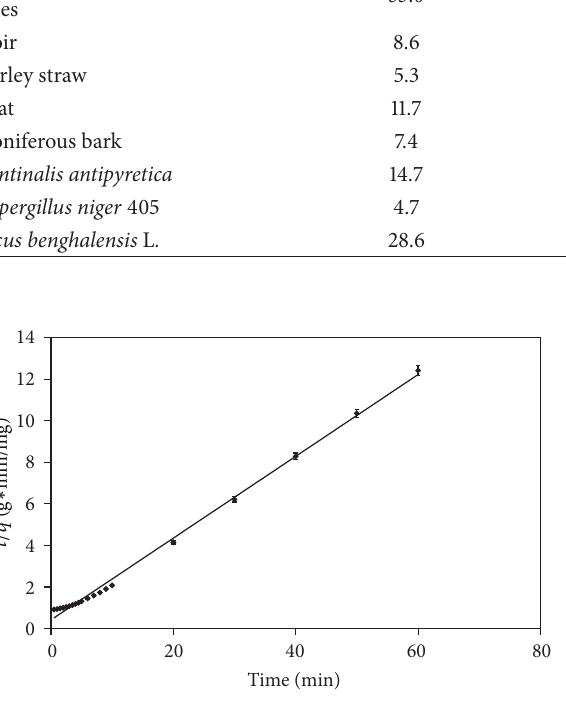
Figure 11: Pseudo-second-order biosorption of lead by Ficus benghalensis L. for 20 mg/L of metal, 0.1g/30 mL of biosorbent concentration, and solution pH of